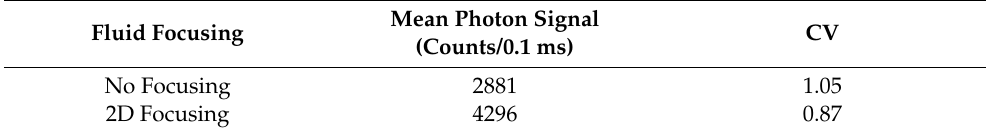
Table 3. Mean and CV for a biosensor illuminated by a line laser.